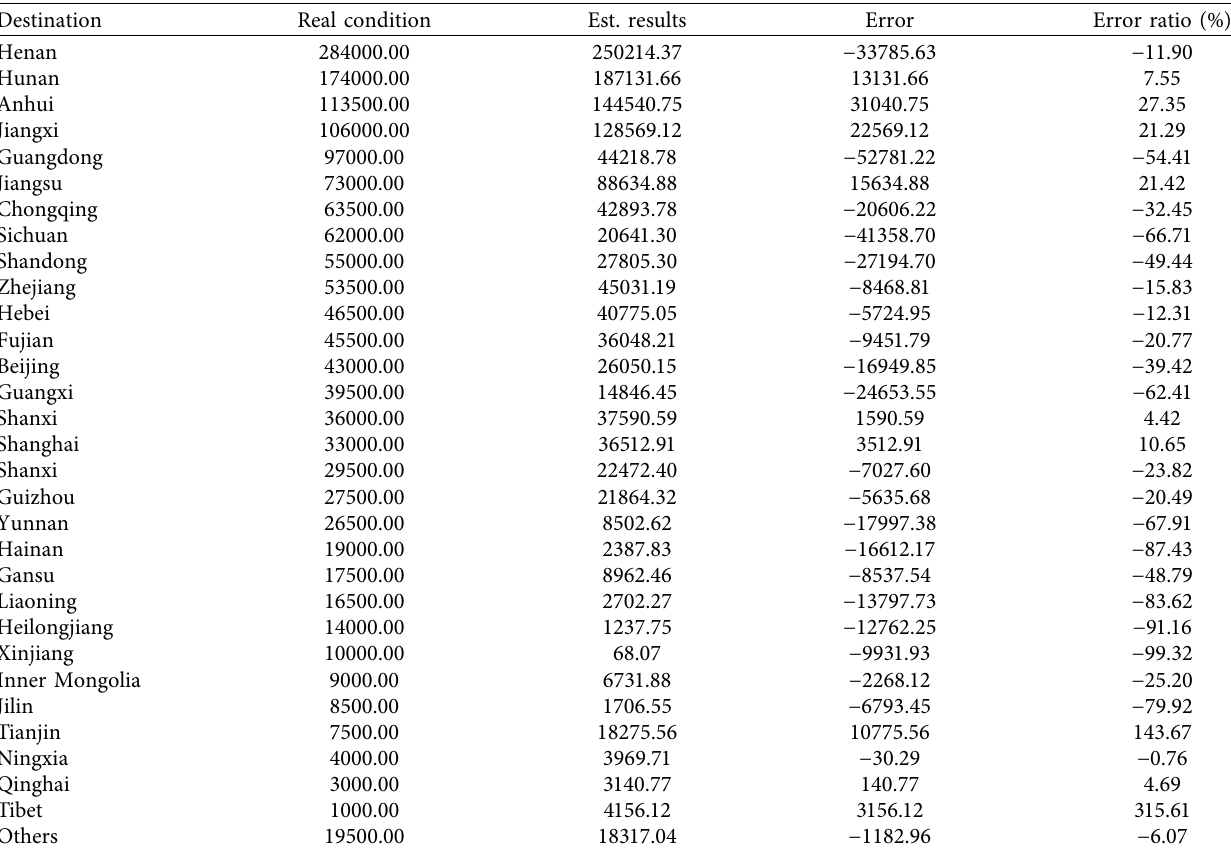
Table 6: Demand distribution estimation and the error of estimation for other province-level destination regions outside the province of